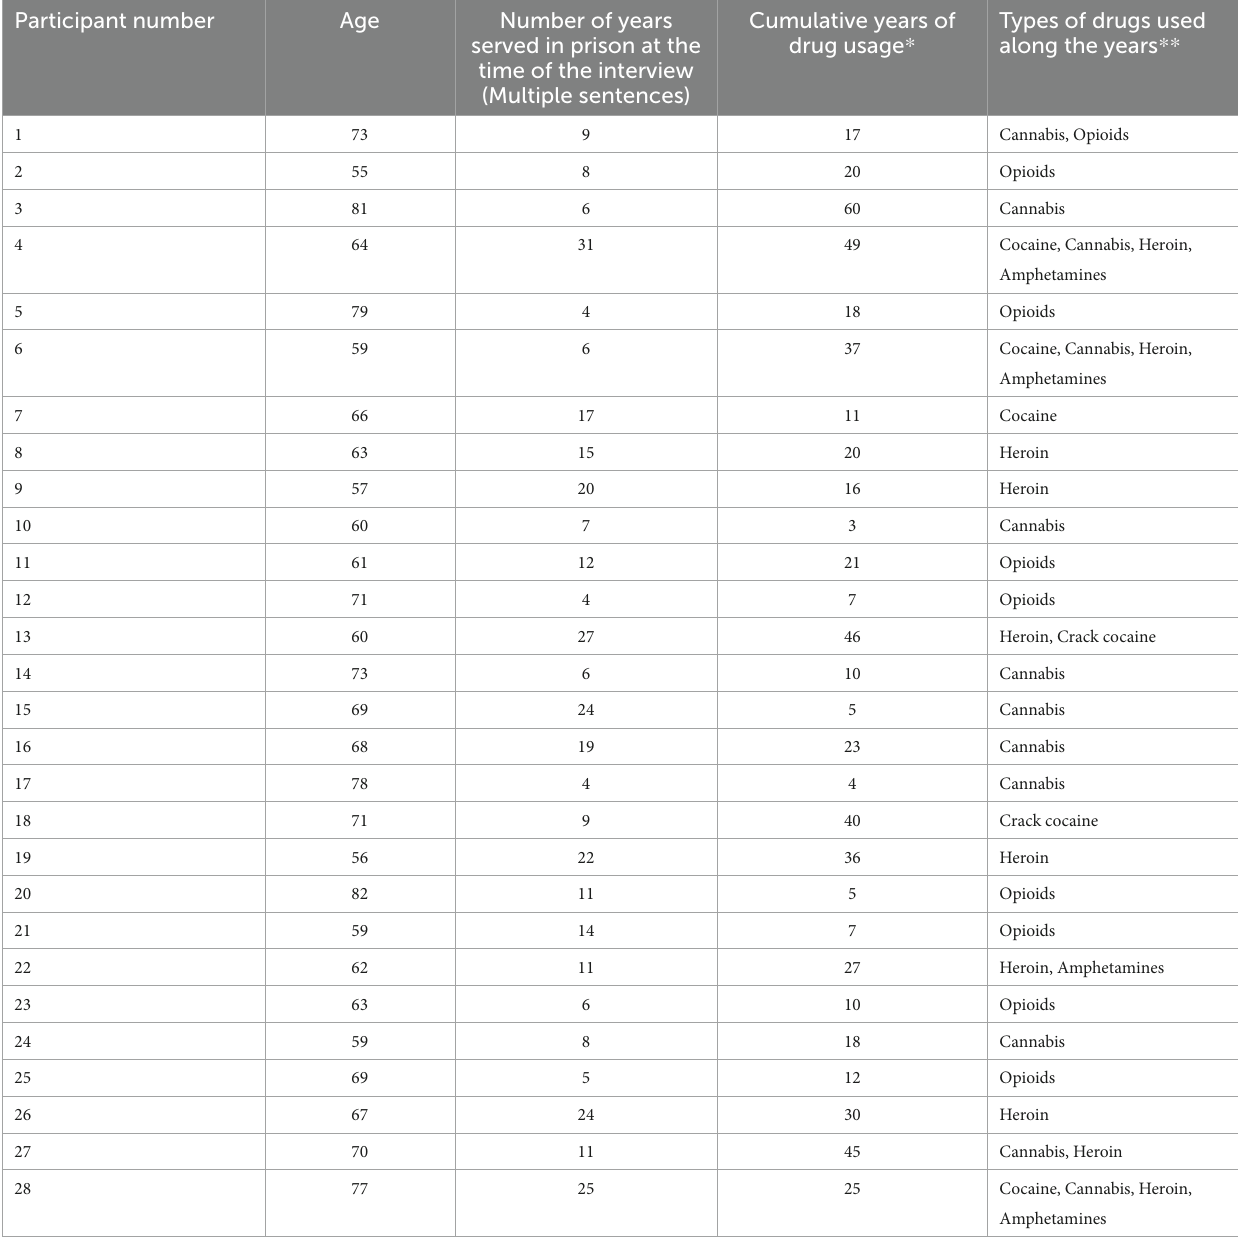
TABLE 1 Sociodemographic characteristics of the participants. Participant number Age Number of years